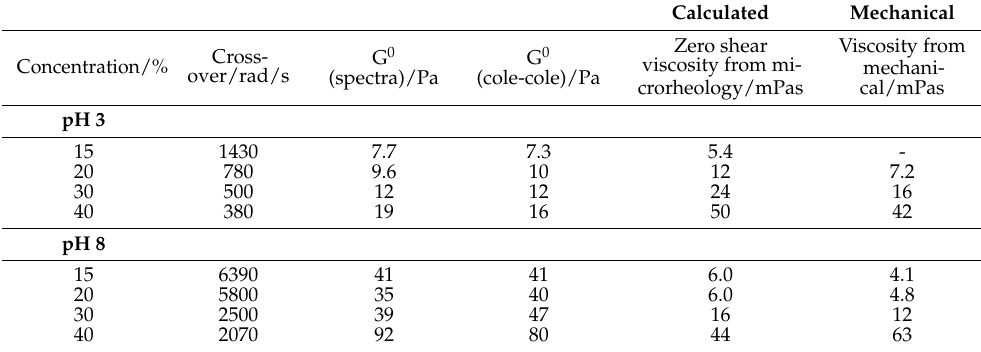
Figure 2. Evolution of the frequency response of G ′ (filled), G ″ (open symbols) of Sophorolipid (SL) in water at different concentrations (mass %) at left) pH 3 right) pH 8. Table 1. Summary of the parameters obtained from (micro-)rheology measurements for different SL concentrations at pH 3 and pH 8.